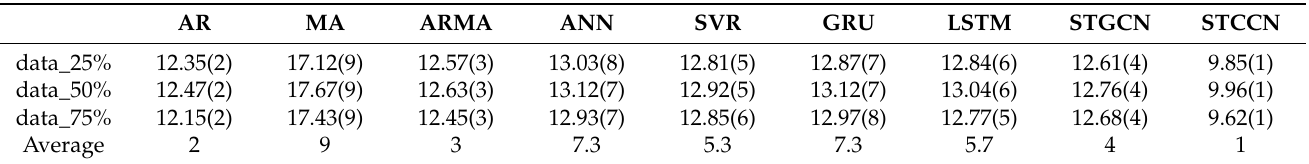
Table 5. RMSE index ranking of 9 models in 3 data